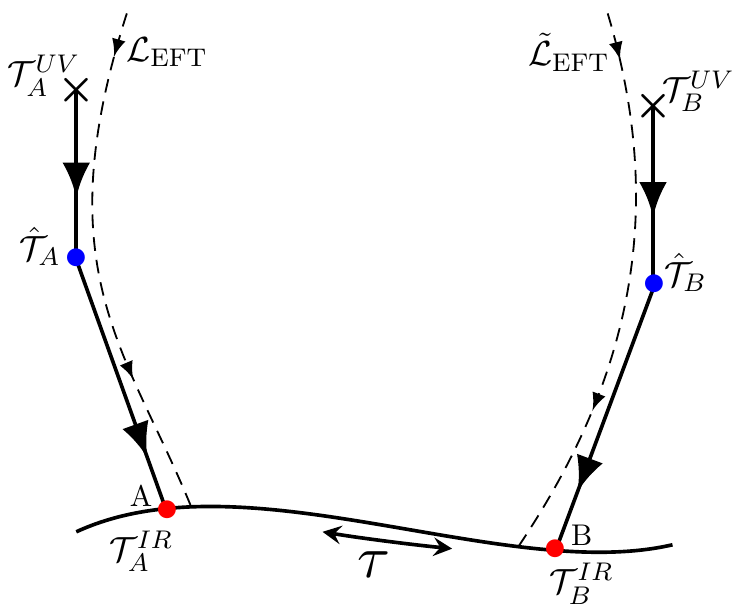
τ Figure 6. A schematic picture of S-duality in N = 1 theories. Beginning with a free UV theory T UV , we turn on a sequence of relevant operators, producing a sequence of RG flows through A intermediate CFTs ˆ T A until we reach an IR CFT T IR with one or more exactly marginal operators. A These operators parameterize a fixed line on which T IR is a special point (typically with enhanced A global symmetries) that we call a “cusp”. The fixed line can be reached directly by turning on all these operators simultaneously in the UV, but as some are dangerously irrelevant, the resulting EFT flow L EFT is typically not UV complete (except when the cusp is a free theory). S-duality occurs when multiple cusps lie on the same fixed line, or when non-trivial paths along the fixed line return to the same cusp